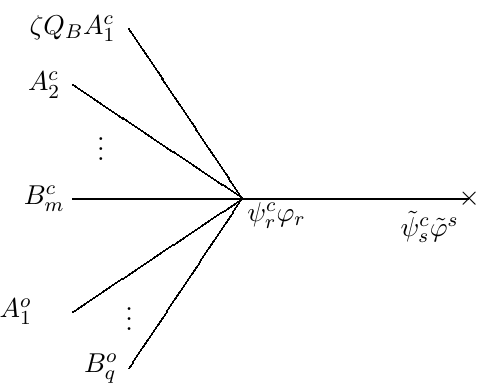
Figure 2 . A Feynman diagram where a 1PI vertex with the external states (cid:16)Q B A c A c ; B c ; (cid:1) (cid:1) (cid:1) ; B c ; A o (cid:1) (cid:1) (cid:1) A o ; B o ; (cid:1) (cid:1) (cid:1) B o and an internal closed string state in H c and another one n m p q 1 1 1 point 1PI vertex with an internal closed string state in e H c are joined by a closed string